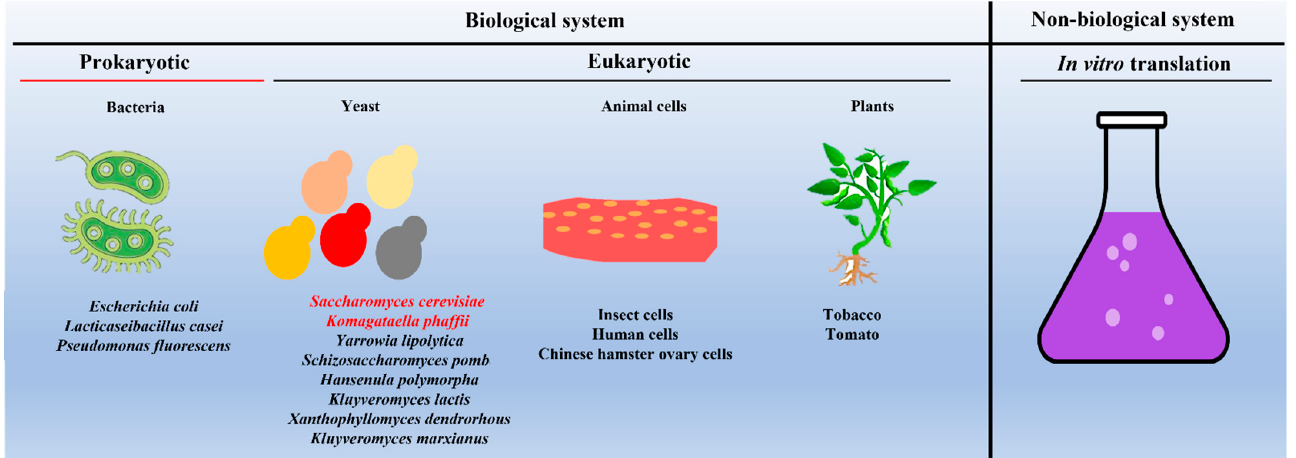
Figure 3. Schematic showing different systems used as hosts for expressing and purifying VLPs. Note: Saccharomyces cerevisiae and Komagataella phaffii (in red font) remain the most commonly used yeast species. In the case of in vitro production of VLPs, one can use the protein translational machinery of either bacteria (prokaryotes) or yeast (eukaryotes).